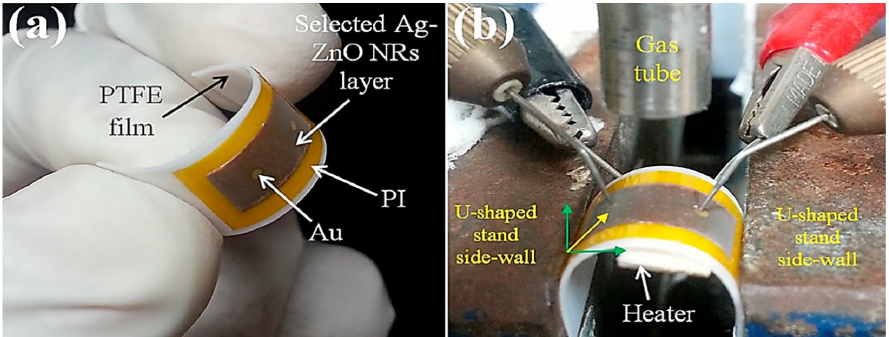
Figure 34. Optical images of ( a ) flexible ZnO NRs gas sensor and ( b ) experimental setup at specific bending angles. Reproduced from [150] with the permission of Elsevier.